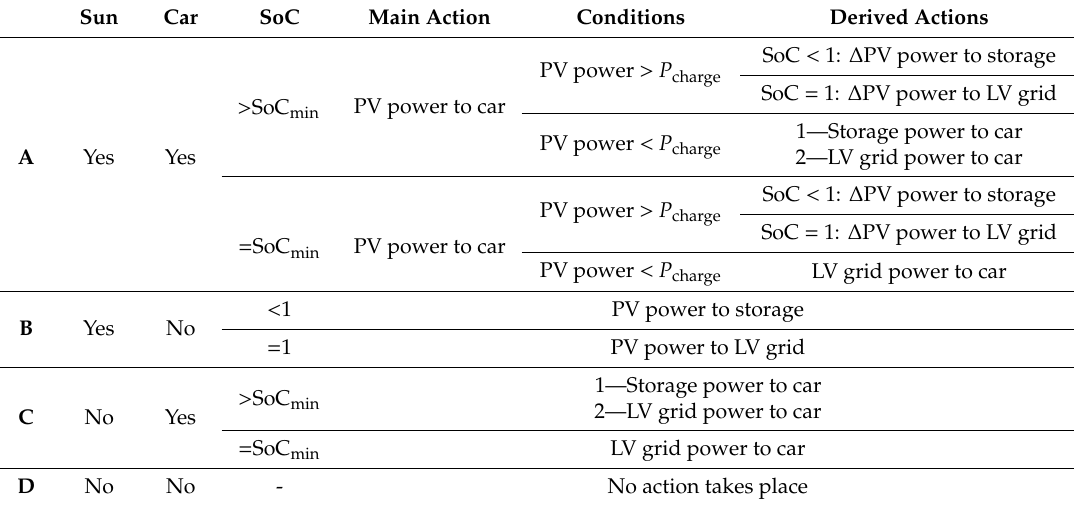
Table 3. Energy-flows model